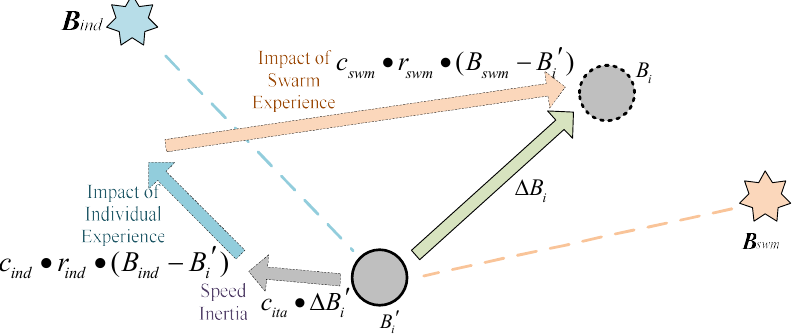
Figure 4. Schematic diagram of search strategy adjustment.